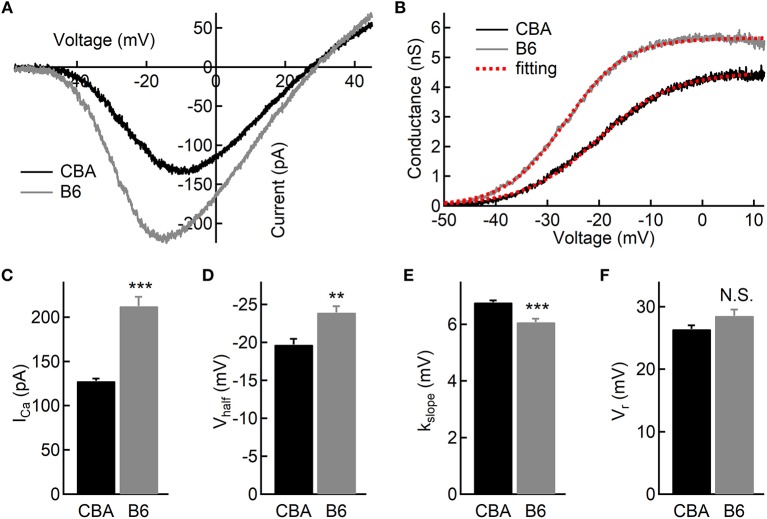
Ca2+ current in inner hair cells (IHCs) of CBA and B6 mice. (A) Representative Ca2+ currents recorded from two IHCs, one from each mouse strain, induced by a voltage ramp from −90 to +50 mV under voltage-clamp. (B) Based on the Ca2+ current shown in (A), the conductance was calculated point-by-point and plotted against the membrane potential applied. The dashed lines in red depict Boltzmann fitting. (C–E) The Ca2+ current in IHCs from B6 mice has a larger peak amplitude (ICa, C), a more negative half-activation voltage (Vhalf, D) and a steeper voltage dependency (kslope, E). (F) No statistical significance was found in the reversal potential of the Ca2+ current (Vr) between the two mouse strains. N.S. means p > 0.05, ** means p < 0.01 and *** means p < 0.001.